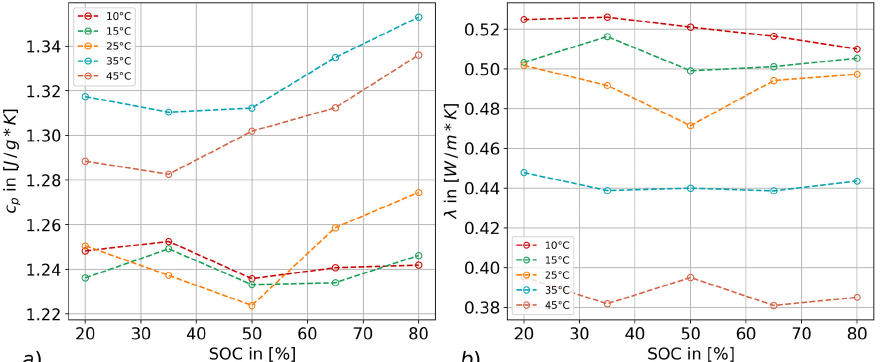
Figure 12. Changing of thermal parameters over SOC range for all covered temperatures. ( a ) Specific heat capacity c p . ( b ) Cross-plane thermal conductivity λ ⊥ .